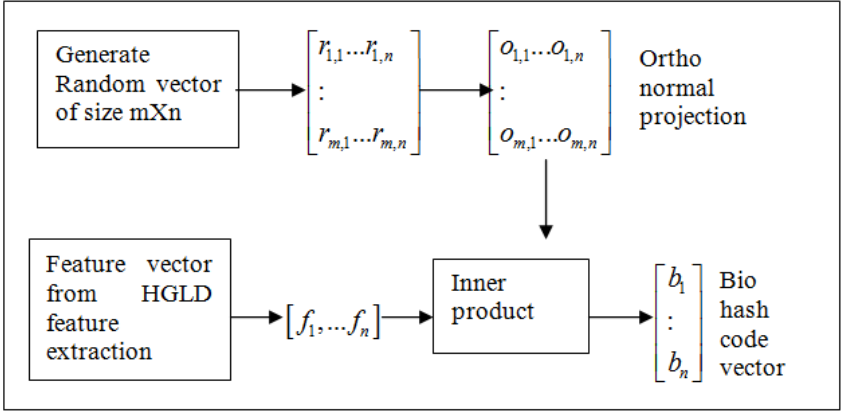
Figure 2. Bio hash function.